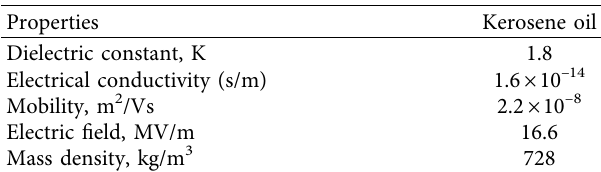
Table 4: Properties of dielectric fluid.